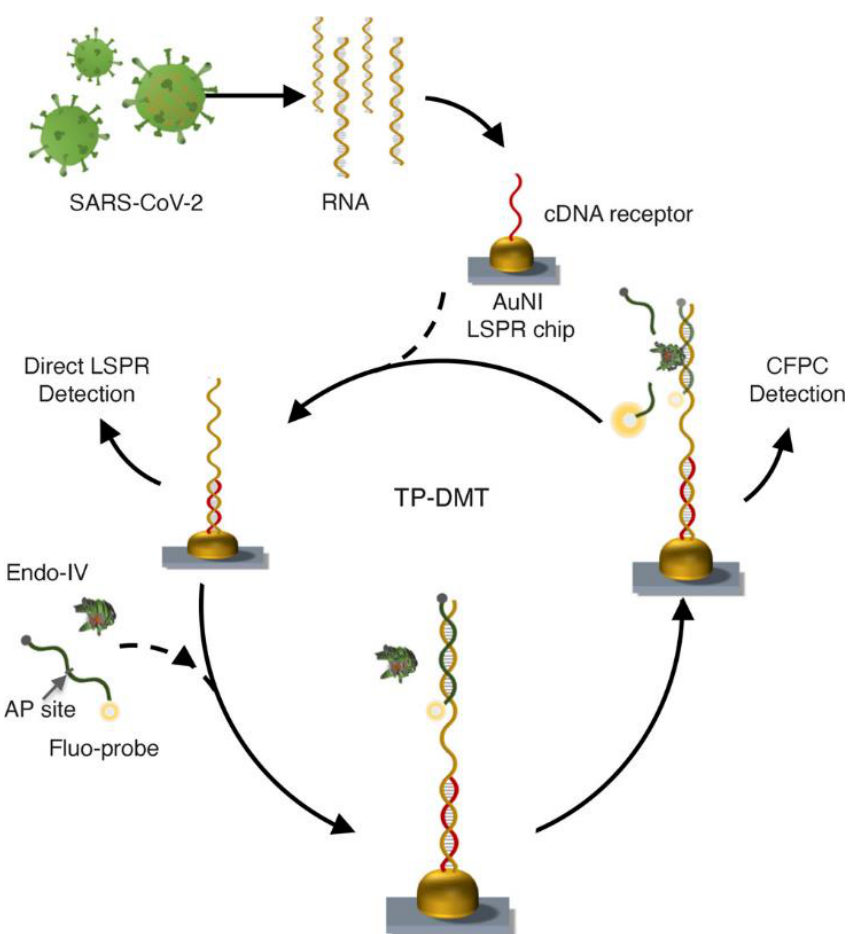
Figure 4. Schematic of TP-DMT viral sensing workflow with two types of approaches, which are the amplification-free-based direct viral RNA detection (direct sensing system) and the amplification-based cyclic fluorescence probe cleavage (CFPC) detection. Reproduced from Qiu et al. [94]. 4.1.3.